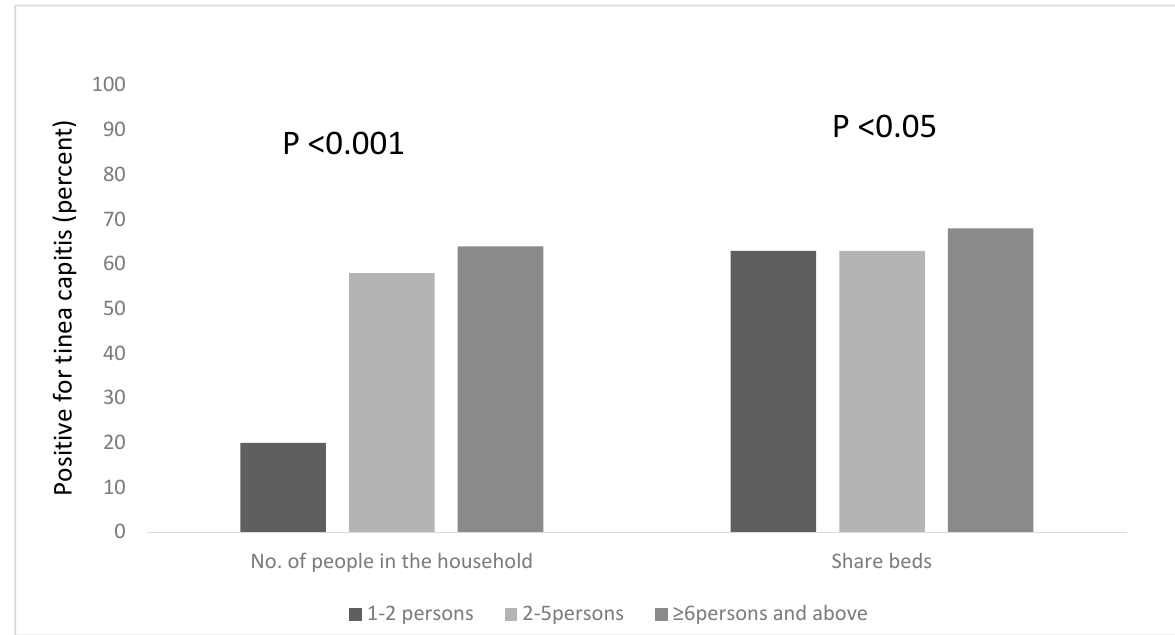
Figure 2. Occurrence of tinea capitis among the participants, based on the number of people in the household and the sharing of beds.